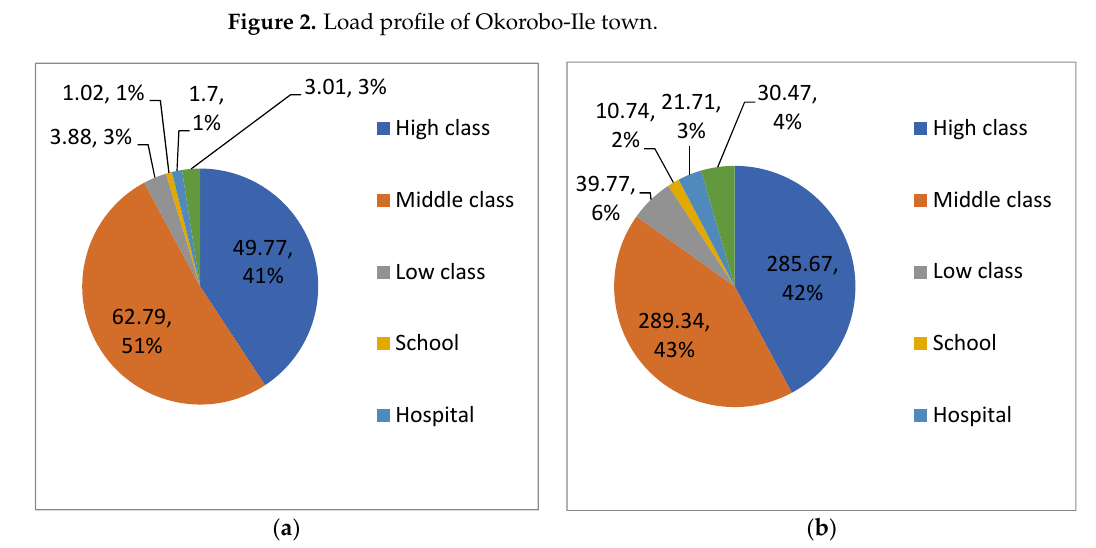
Figure 3. Community load distribution: ( a ) peak, ( b ) daily.